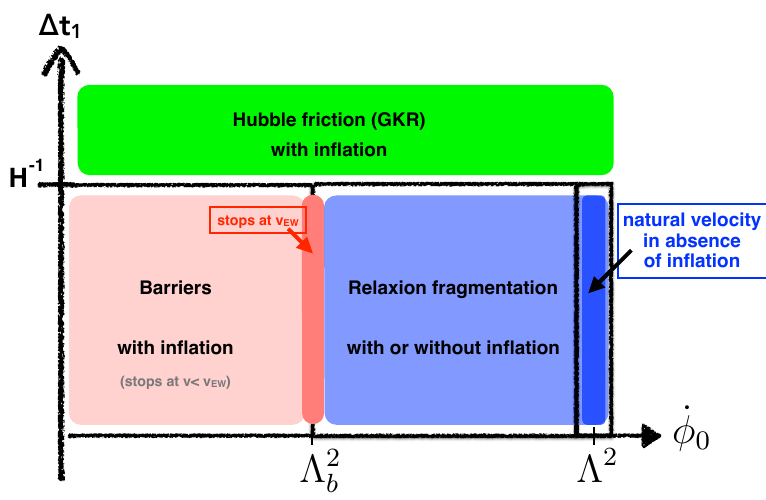
Figure 1 . Sketch of relaxion stopping mechanisms. The initial velocity _ (cid:30) 0 is either the relaxion velocity before the barriers appear in models with Higgs-dependent barriers, or the velocity before particle production starts in models where relaxion stops due to particle production (either relaxion particles or EW gauge bosons). (cid:1) t 1 is the time scale it takes for the relaxion to roll over a distance 2 (cid:25)f , to be compared to the Hubble time H (cid:0) 1 . The (cid:12)nal size of the barriers is (cid:3) b while the cuto(cid:11) scale is (cid:3). In our notation (see eq. (3.1)), (cid:3) b is the size of the barriers when the relaxion stops at h = v . In the red region, corresponding to the ‘large barriers’ case of section 3.1, the relaxion EW h i stops when the barriers amplitude equals the initial kinetic energy. Thus, for _ (cid:30) 2 value of the Higgs vev would be lower than the measured one (light red